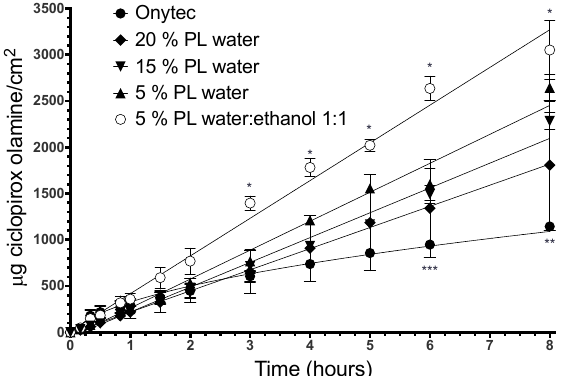
Figure 6. Release profiles (mean ± SD, n = 6) of aqueous lacquers made with different proportions of Poloxamer 407 and of the lacquer made with a 1:1 water–alcohol mixture and 5% poloxamer 407. * indicates significant differences between 5% PL water:ethanol 1:1 and the rest of lacquers ( α < 0.05); ** indicates significant differences between OnyTec ® . and the rest of lacquers ( α < 0.05); *** indicates significant differences between OnyTec ® and 5% PL water.